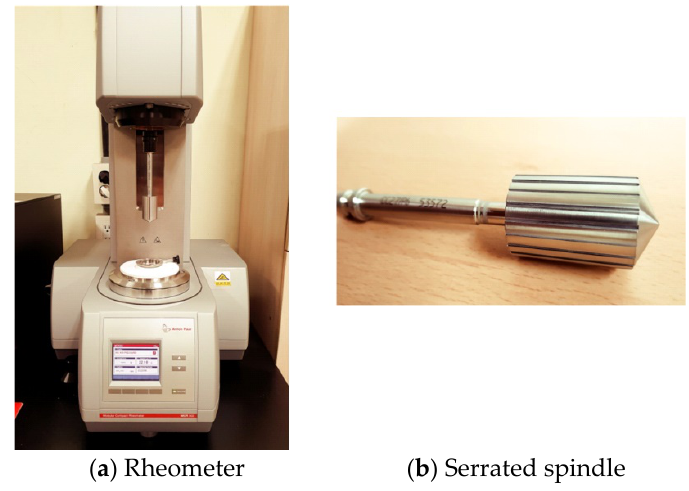
Figure 1. The rheology measurement system.